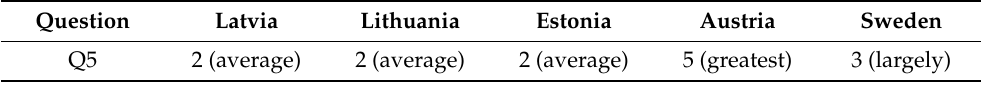
Table 5. The scores of the expert assessment from transnational comparison, respectively, according to question